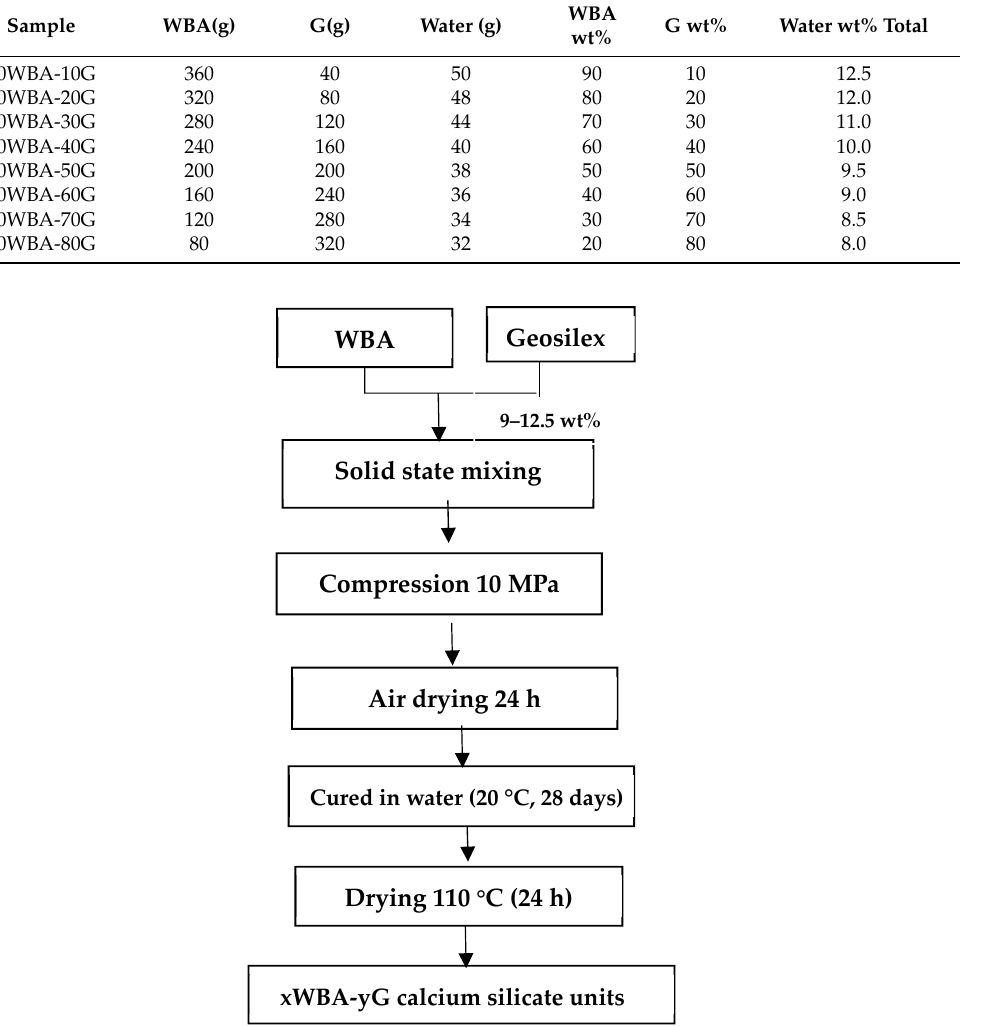
Figure 2. Flowchart of producing calcium silicate units using as raw materials wood bottom ash (WBA) and GeoSilex (G).